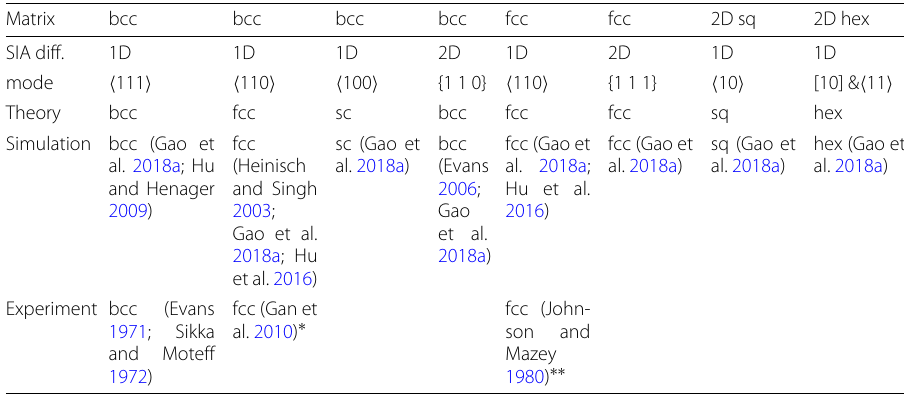
Table 1 Theoretical predictions of void/bubble ordering versus atomic kinetic Monte Carlo simulations and experimental observations